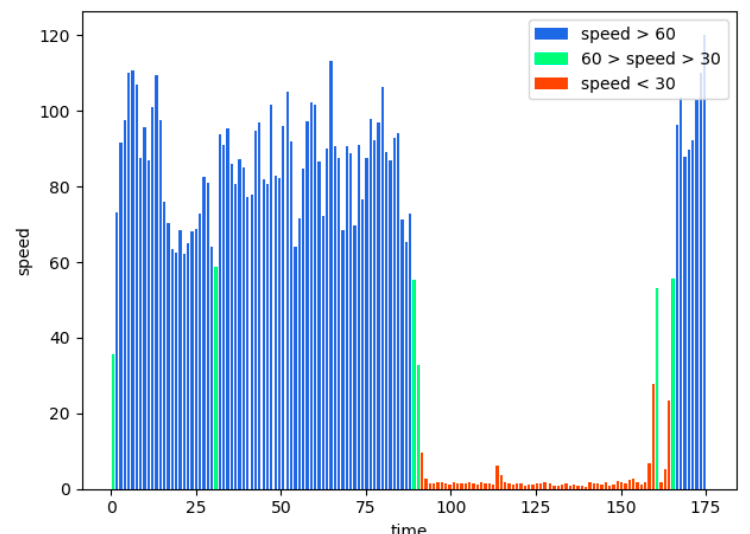
Figure 6. Speed distribution of single signal period.